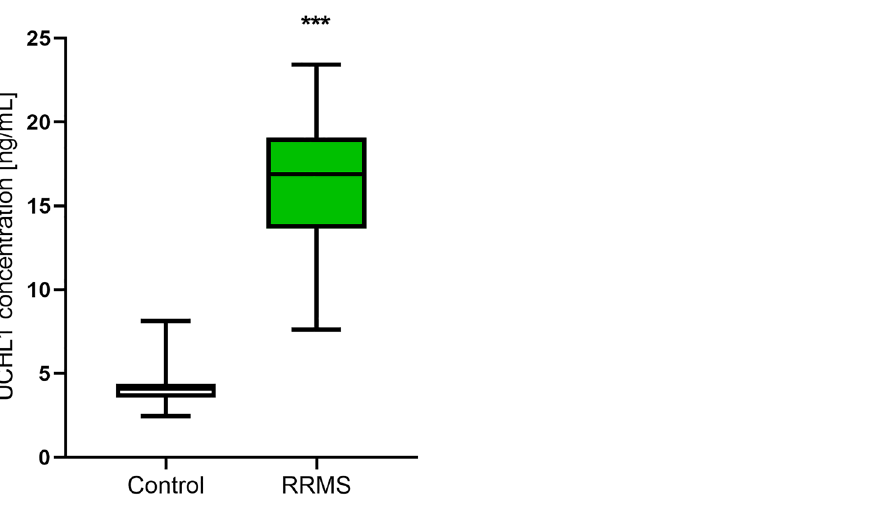
Figure 3. Plasma UCHL1 concentration in relapse-remitting multiple sclerosis patients (RRMS) as compared to the healthy control individuals. Statistical significance ***p ≤ 0.001.